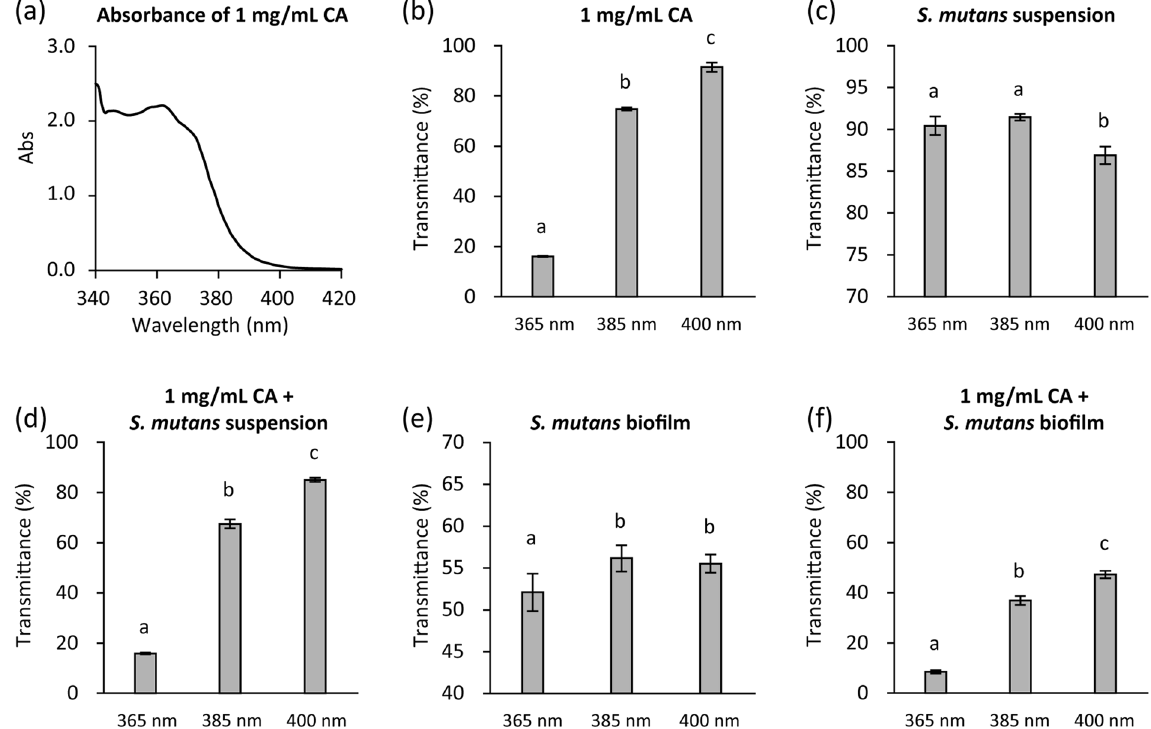
Figure 7. UV-Visible absorption spectrum of caffeic acid (CA) solution ( a ) and transmittance of LED light through each sample ( b – f ). The UV-visible absorption spectrum of 1 mg/mL CA prepared in pure water was obtained using a spectrophotometer. The transmittance was calculated as follows: transmittance, % = (power of transmitted light through the sample/blank) × 100. The test samples were 1 mg/mL CA, S . mutans suspension with 5 × 10 7 CFU/mL, S . mutans biofilms, and combinations thereof. Values and error bars indicate the mean and standard deviation, respectively. Different letters above the columns refer to significant differences ( p < 0.05) between different